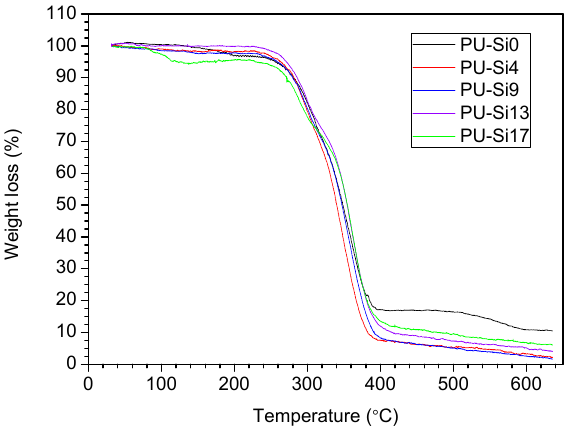
Figure 4. Thermogravimetric analysis (TGA) curves of the PU-Sis samples.